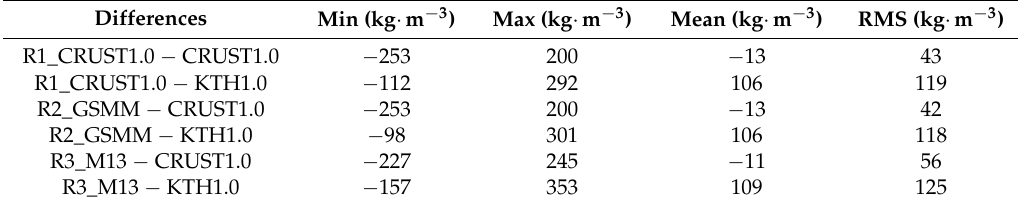
Table 5. Statistics of the Moho density contrast differences.